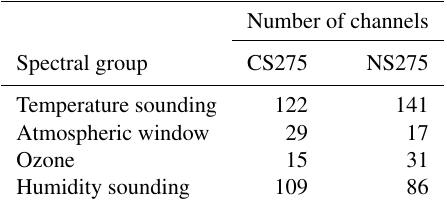
Table 2. Spectral band comparison between Collard’s and the new channel